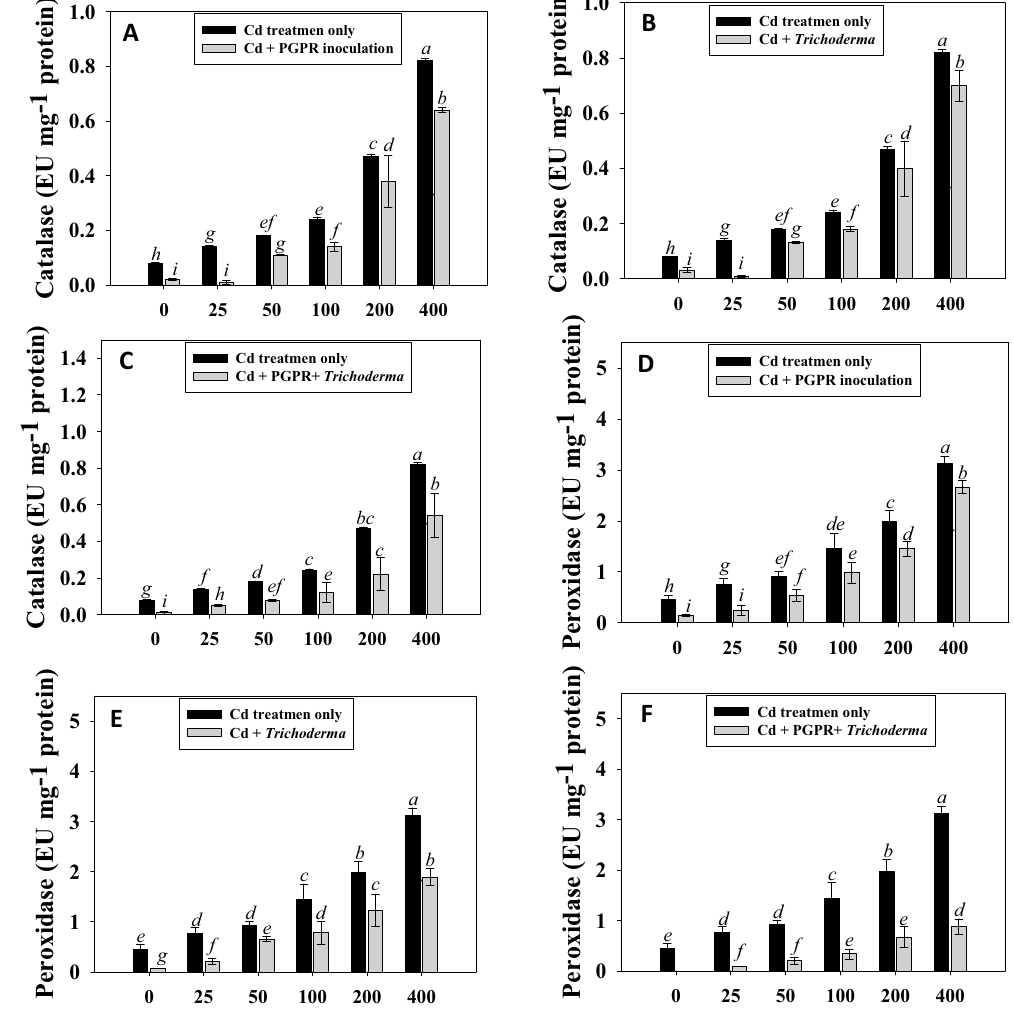
Figure 4. Antioxidant enzymes; catalase ( A – C ) and peroxidase ( D – F ) activities in cadmium supplemented and inoculated (either single/combined) with PGPR-7, Trichoderma sp. T4 strain. Each bar diagram represents the mean of three replicates ( n = 3). Corresponding error bars represent standard deviation (S. D.) of replicates. Different letters represent that mean values are significantly different according to DMRT